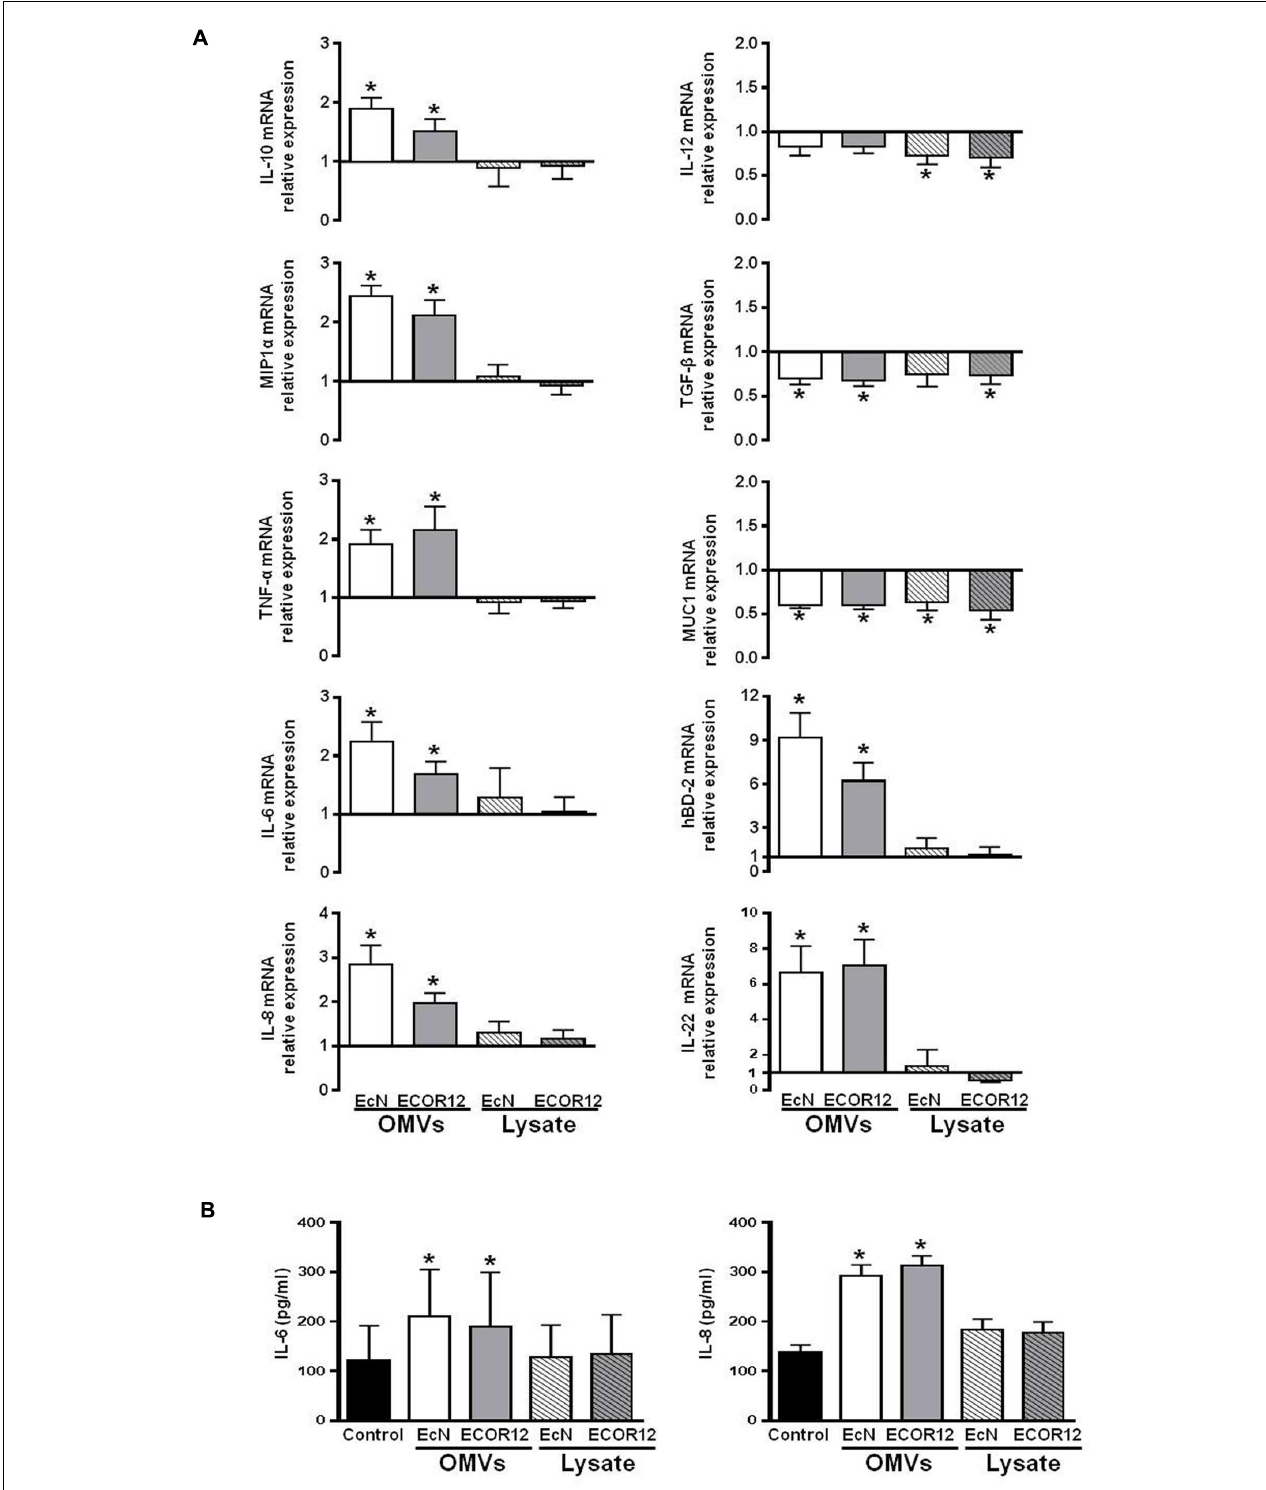
FIGURE 5 | Expression levels of the indicated immunomodulatory and defense mediators in human colonic explants. Colonic tissues were challenged for 5 h with OMVs or bacterial lysates from EcN or ECOR12 strains. (A) Relative mRNA levels of the indicated mediators. Data are presented as fold-change compared to untreated colon fragments. (B) IL-8 and IL-6 protein levels in culture supernatants. Data are presented as mean ± SEM. Statistical differences were assessed by the t- test. ∗ p ≤ 0.05, versus control.